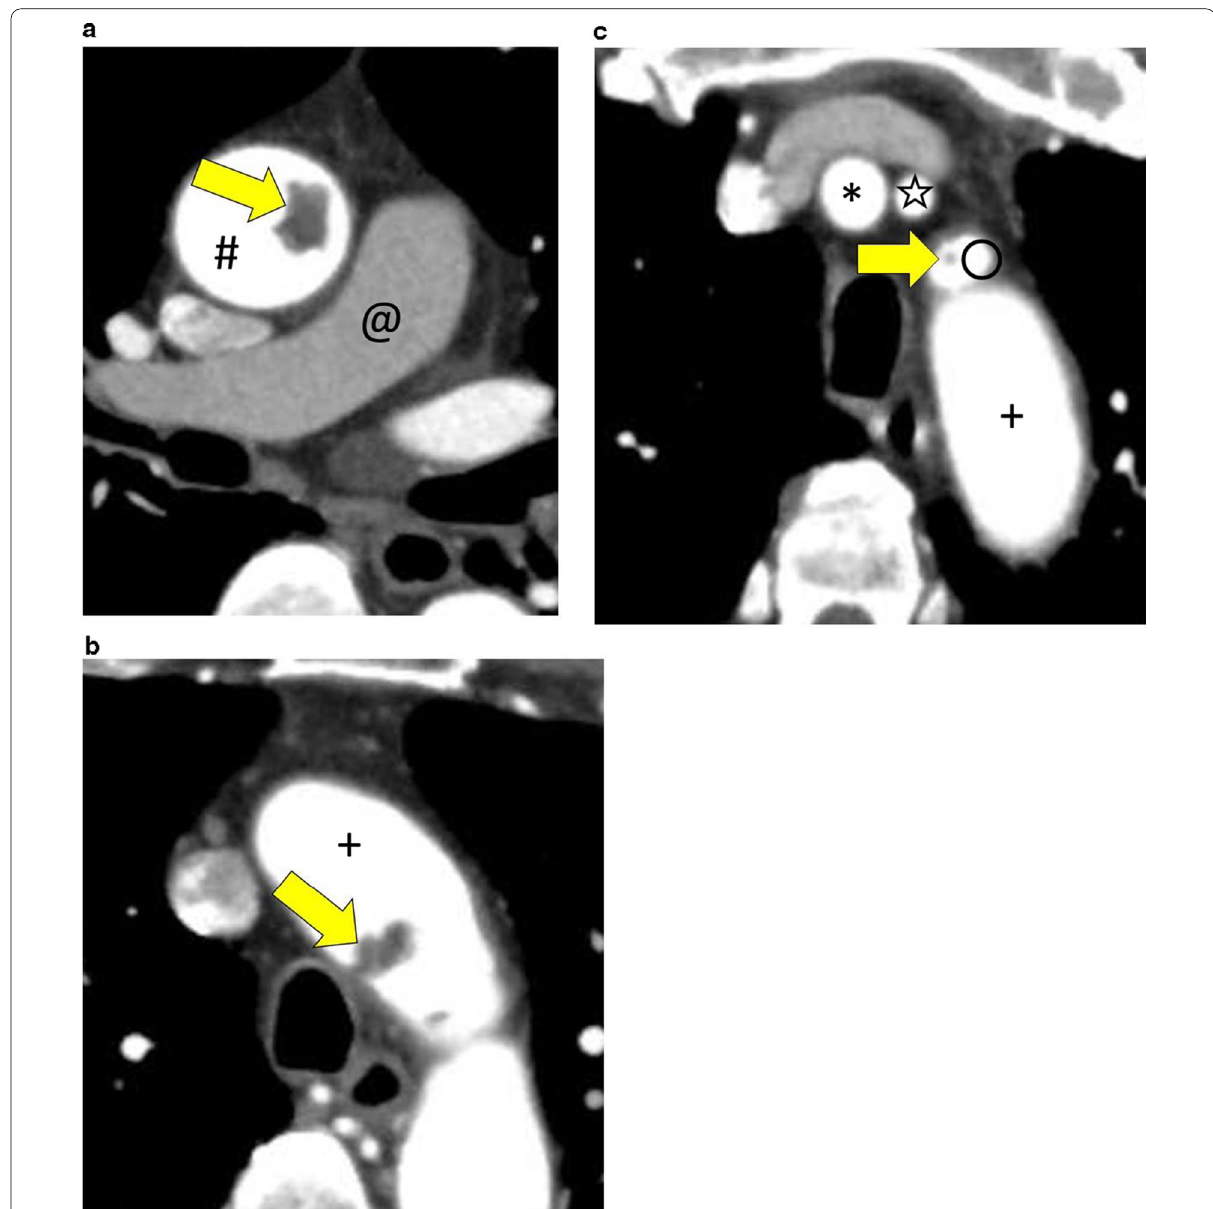
Fig. 3 CT images. a An axial CT image showing the thrombus in the ascending aorta (arrow). b An axial CT image showing the thrombus in the aortic arch (arrow). c An axial CT image showing the thrombus in the left subclavian artery (arrow). # Ascending aorta, @ pulmonary artery, arch, * brachiocephalic artery, open star left common carotid artery, open circle left subclavian